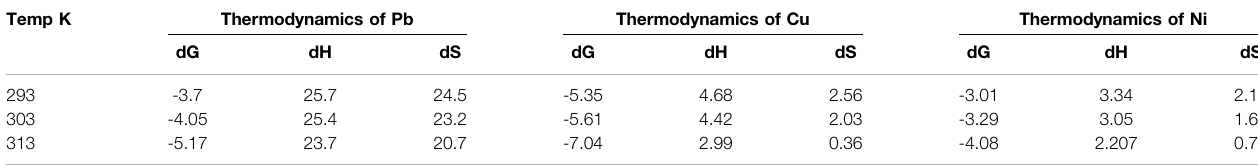
TABLE 4 | Thermodynamics parameters of Pb, Cu, and Ni adsorption on the PANI-WH composite.